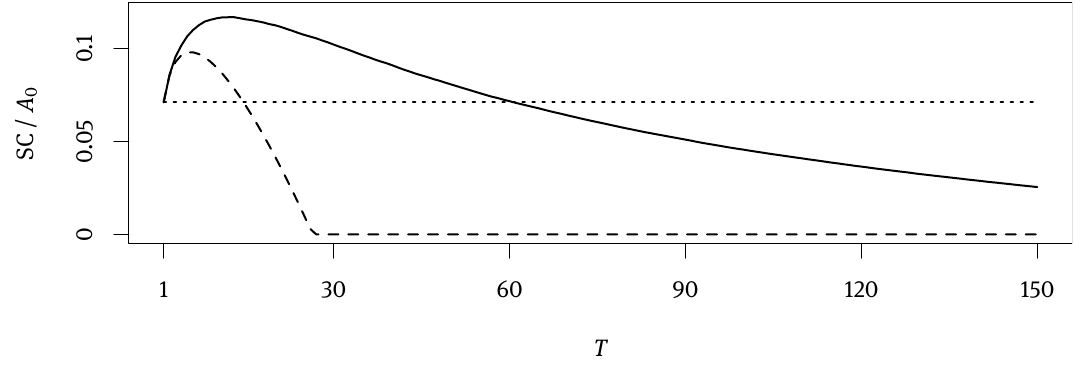
Figure 2: Solvency capital with the equity model in proportion of the inital value of the portfolio under SII (dotted line), at matu- rity (dashed line) and at ruin (solid